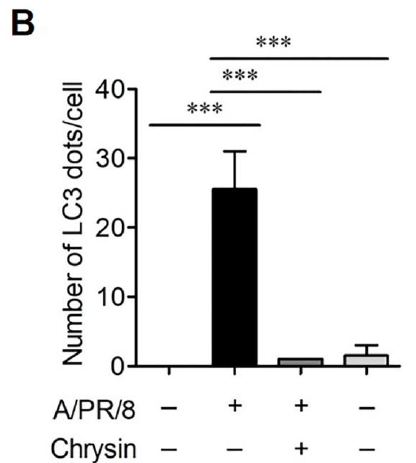
Figure 5. Chrysin blocked autophagy in the A/PR/8-infected A549 cells. ( A ) Representative image of LC3 staining in A/PR/8-infected and non-infected A549 cells treated with 50 µ M chrysin for 24 h. The LC3 puncta was observed under a confocal microscope. Red signals represent LC3; blue signals represent DAPI-stained nuclei. Scale bar, 5 µ m. ( B ) The number of RFP-LC3 dots per cell was counted. Data are expressed as mean ± SD of the values obtained from three independent experiments. *** p < 0.0001 based on ANOVA with Bonferroni’s multiple comparison test.